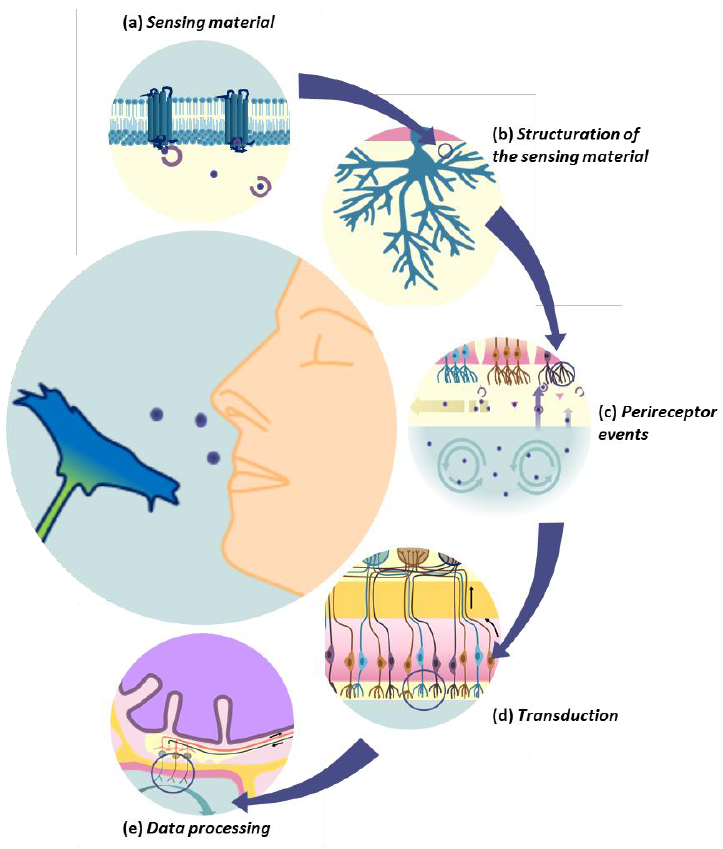
Figure 1. Main constituents and functions involved in the biological olfaction that serve as sources of inspiration for the design of high-performance artificial noses.